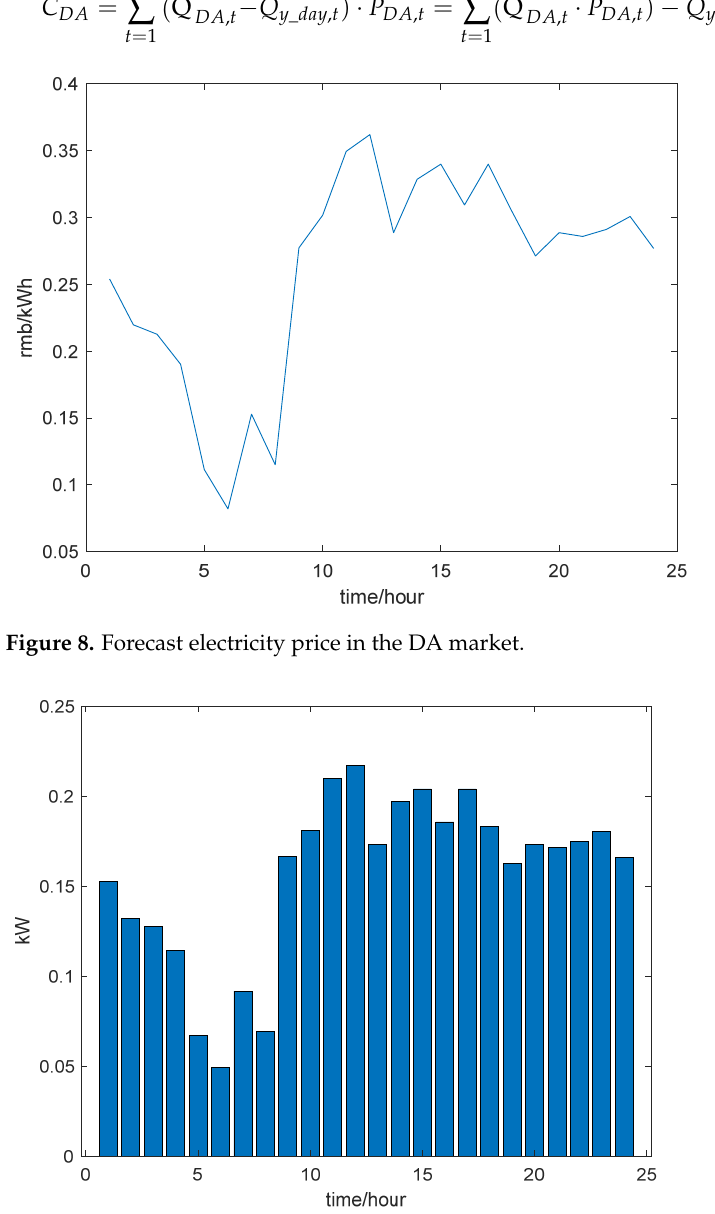
Figure 9. Decomposition load curve of daily electricity.